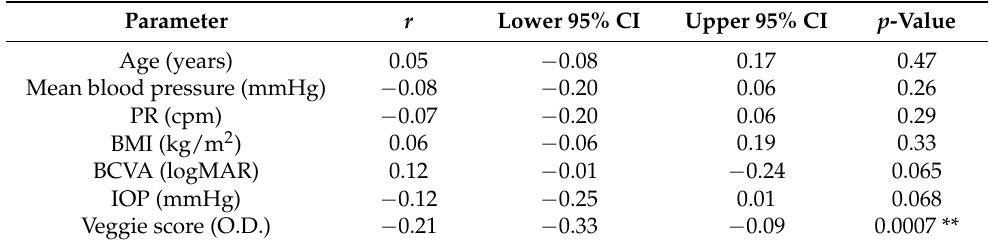
Table 4. Possible associations between the AGEs score (A.U.) and various continuous